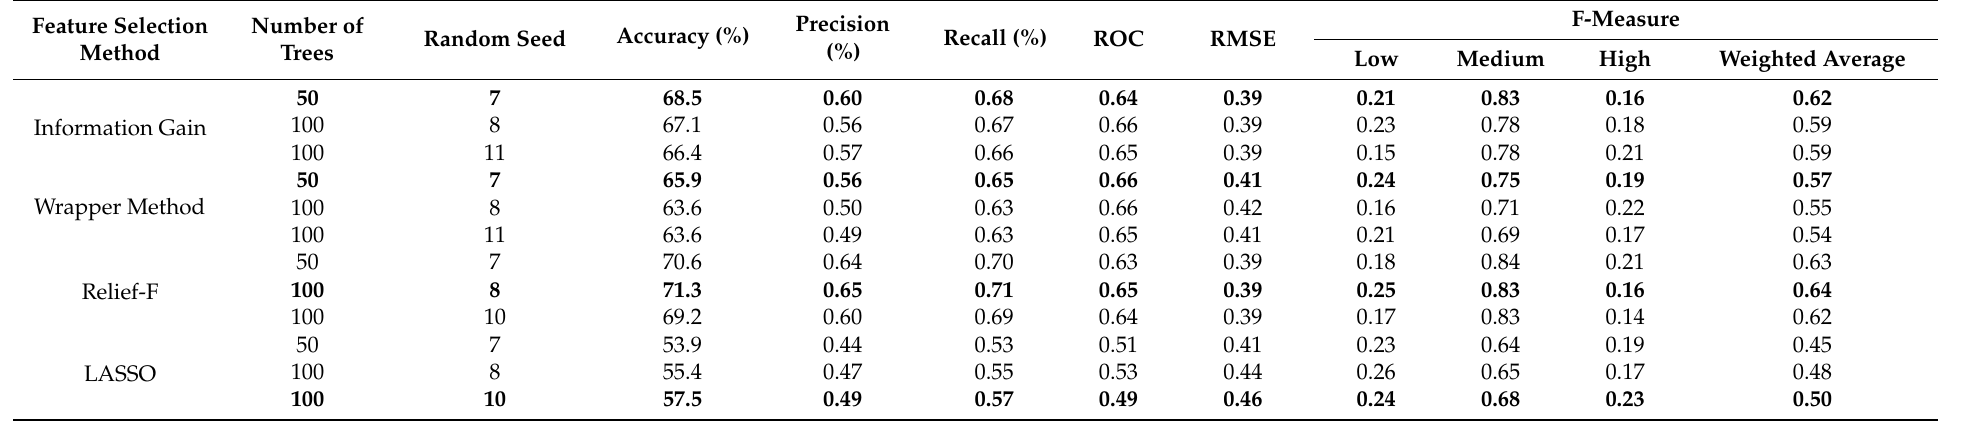
Table 6. Performance of random forest classifier through various feature selection